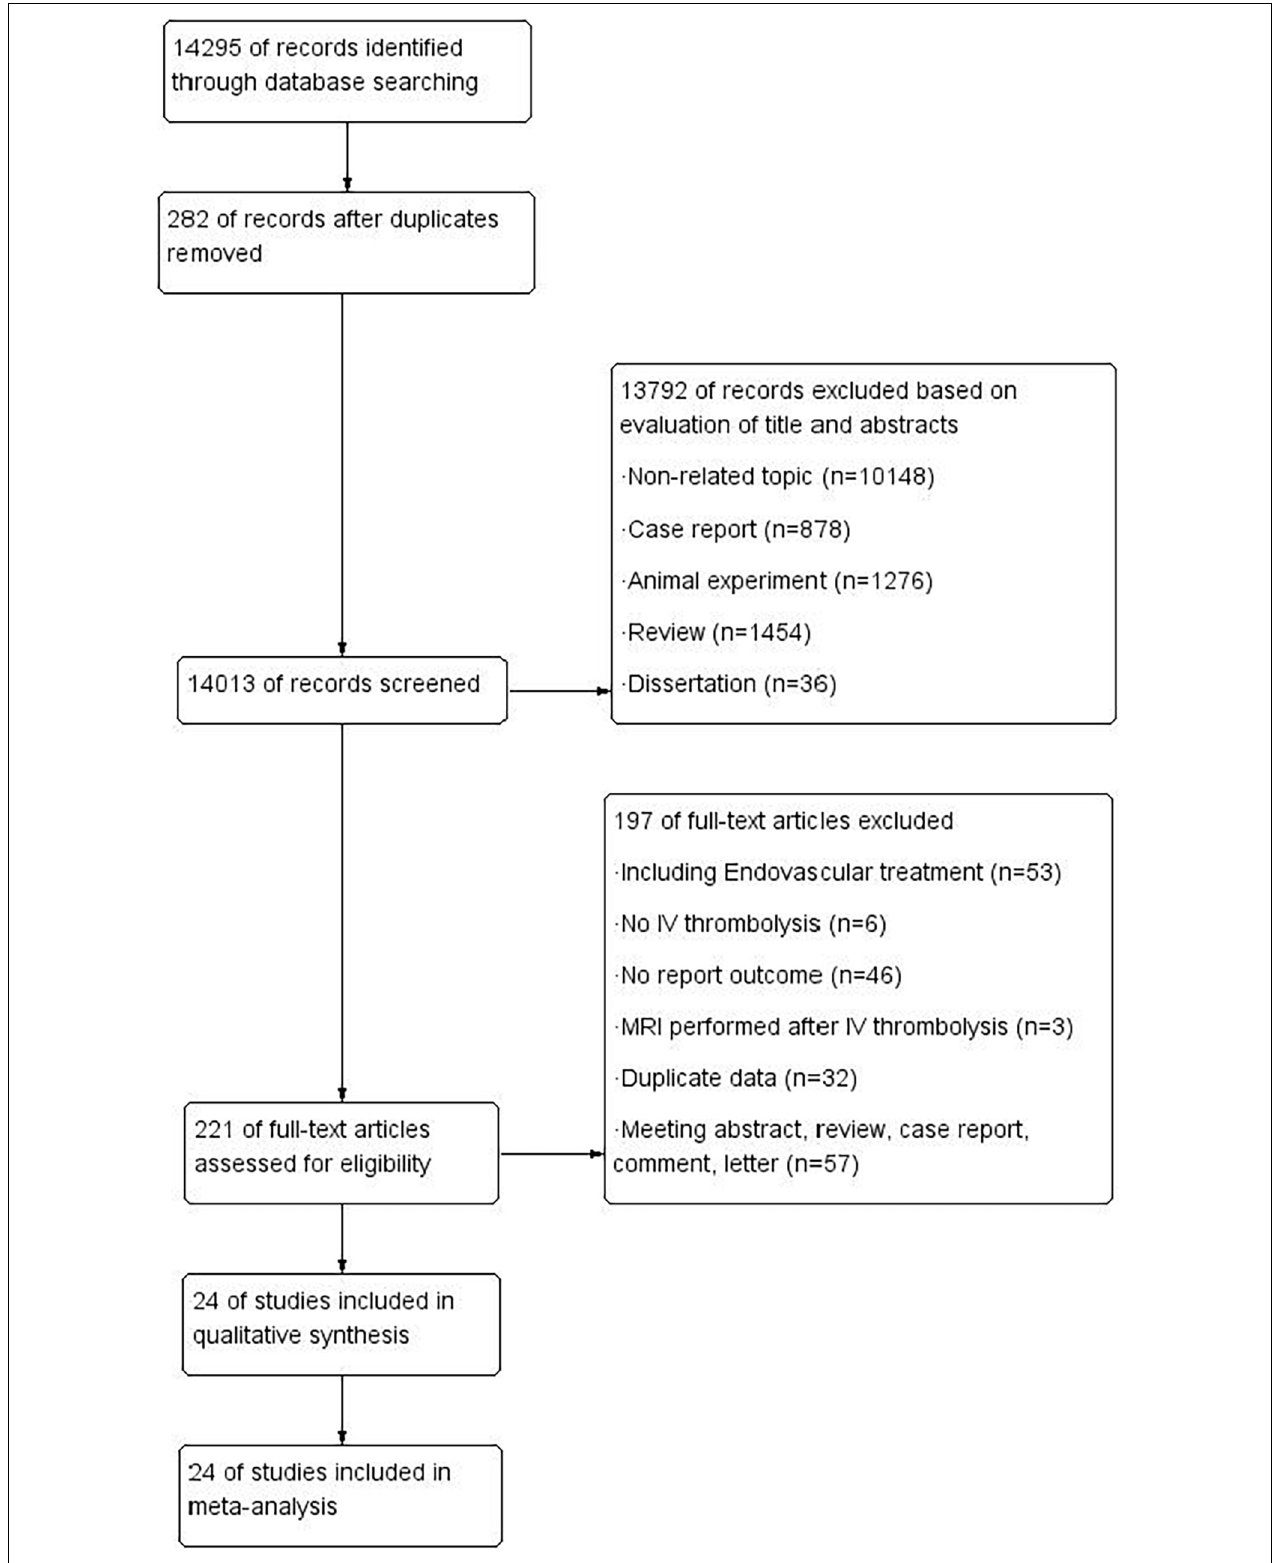
FIGURE 1 | Flow diagram of the search process and study selection.